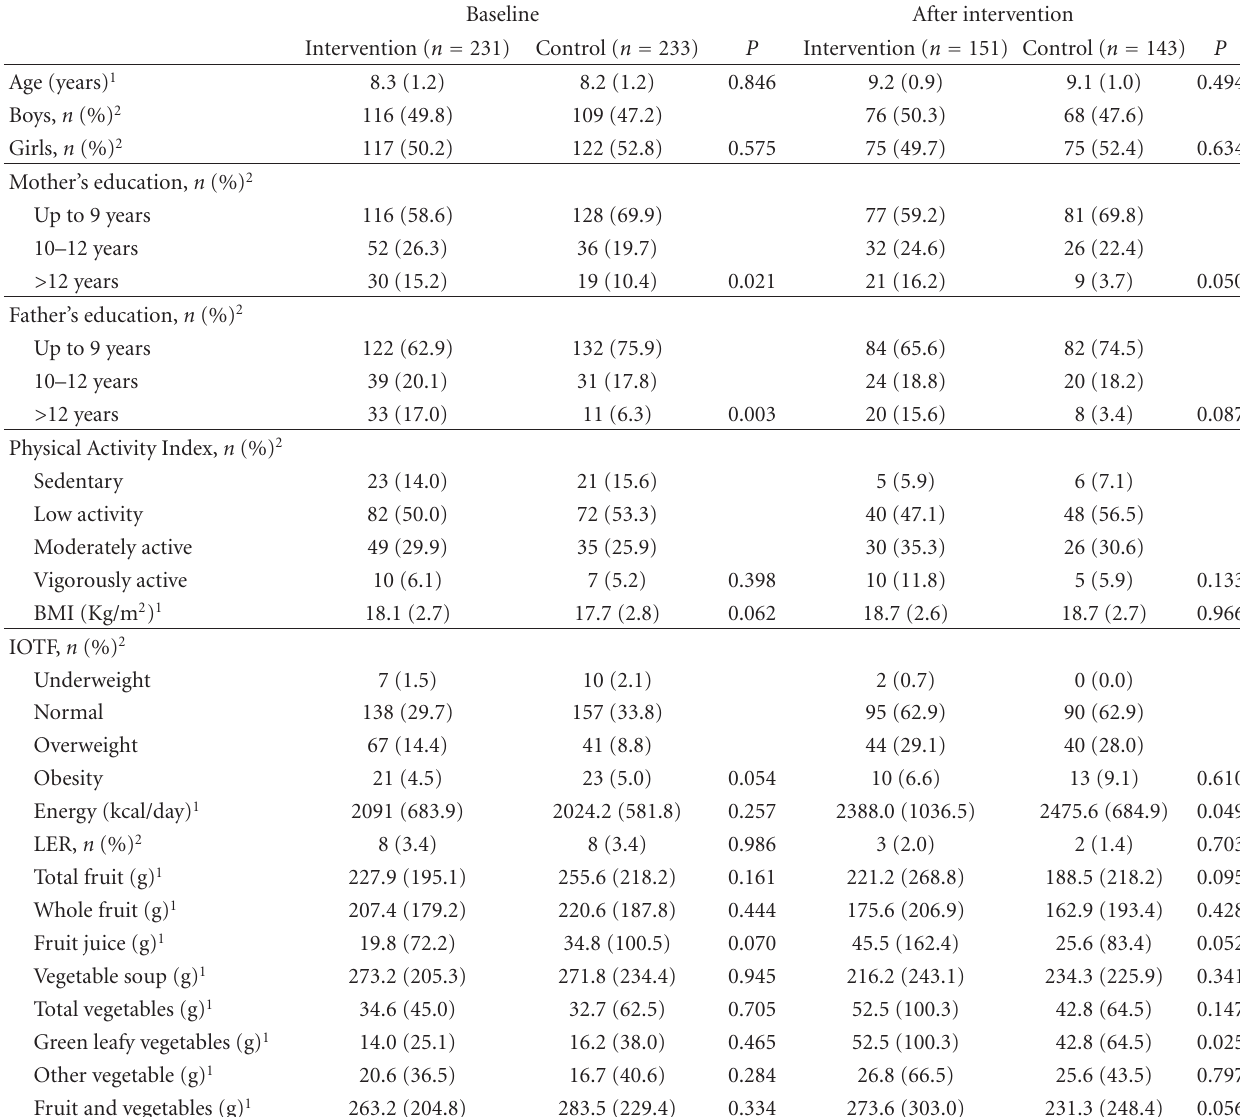
Table 1: Anthropometric and sociodemographic characteristics at baseline and after intervention.